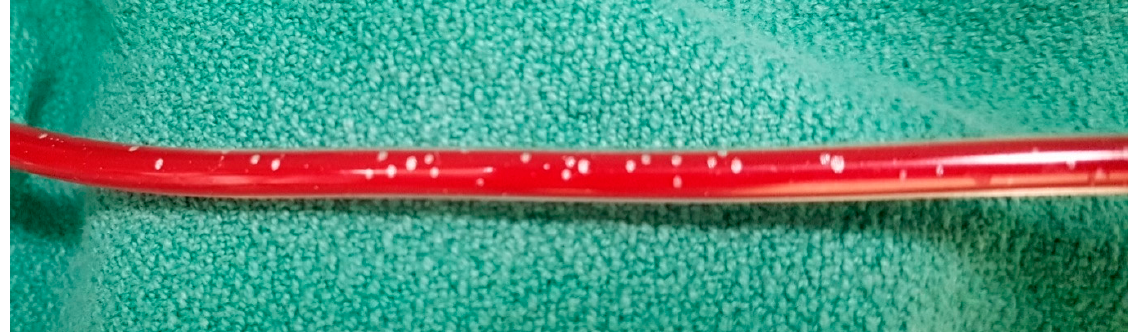
Figure 8. Gas bubbles in a heated fluid.